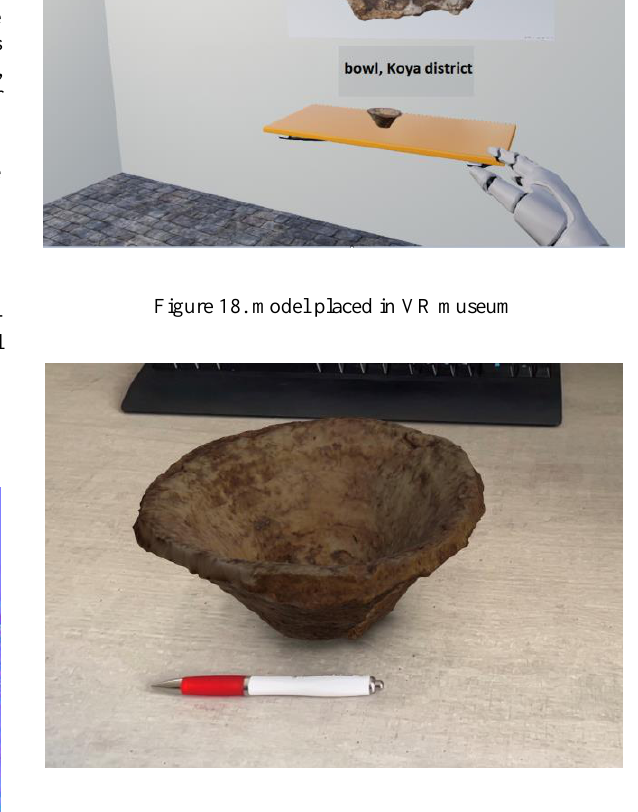
Figure 19. AR model displayed on smartphone (iOS)